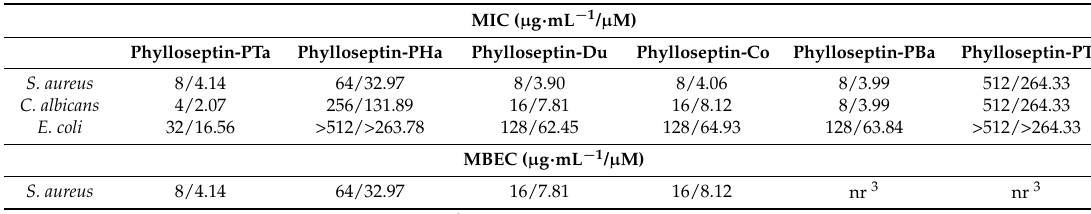
Table 4. The comparisons of phylloseptin-PTa with the recently reported phylloseptins in terms of characteristics and biological